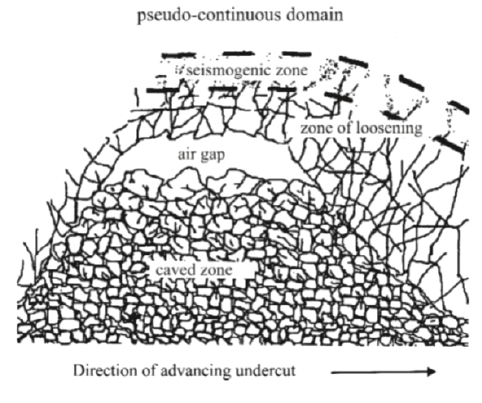
Fig. 2. Conceptual model of caving (after Duplancic and Brady